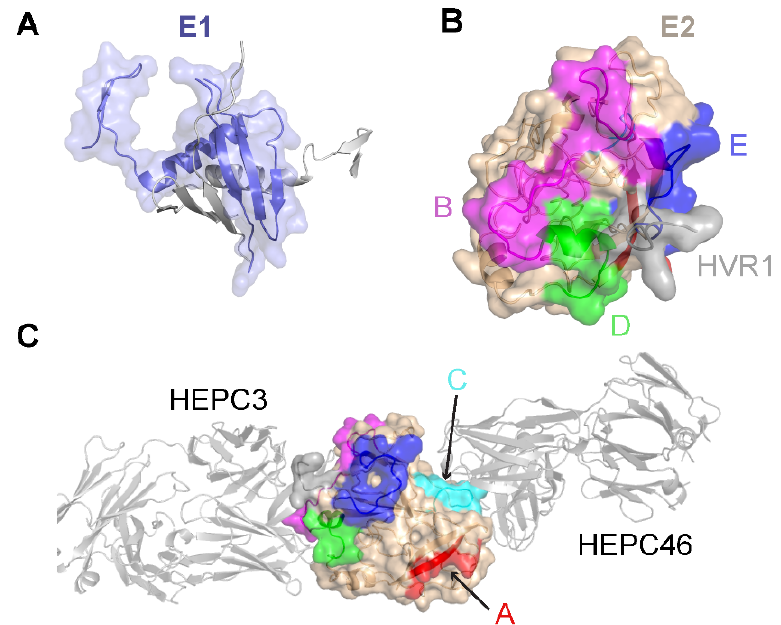
Figure 1. Structures of the E1 and E2 glycoproteins. ( A ) The structure of a truncated E1 glycoprotein ectodomain (PDB: 4UOI), with resolved residues encompassing positions 192–270. An E1 monomer (slate; surface and cartoon representation) is shown with a second E1 monomer (gray) representing the dimeric partner from the X-ray structure assembly. ( B ) The truncated E2 glycoprotein ectodomain structure (PDB: 6MEJ), encompassing E2 residues 405–645, showing the E2 neutralizing face and antigenic domains B, D, and E. Representative residues from the antigenic domains are colored as indicated by the letters, and resolved residues from hypervariable region 1 (HVR1) (residues 405–410) are colored gray. Other residues in E2 are colored tan. ( C ) The same E2 glycoprotein structure as in ( B ), reoriented to show antigenic domains A and C (colored by representative residues and labeled). Bound antibodies HEPC3 (antigenic domain B antibody) and HEPC46 (antigenic domain C antibody), both in gray cartoon, are shown for reference. The neutralizing face is colored as in panel ( B ).